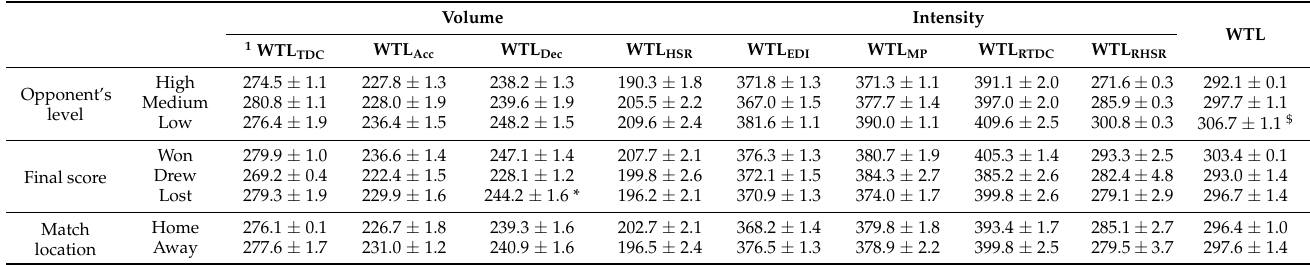
Table 4. Description of the WTL in each of the performance variables according to the opponent’s level, final score and location of the match.